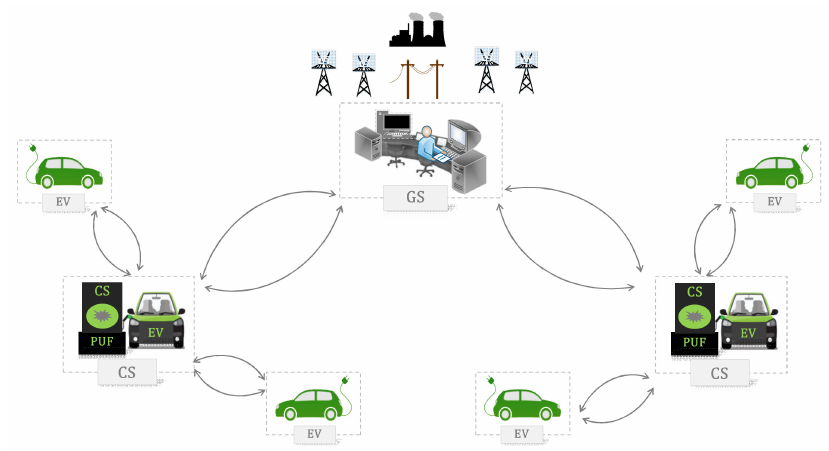
Figure 2. Vehicle-to-grid (V2G)